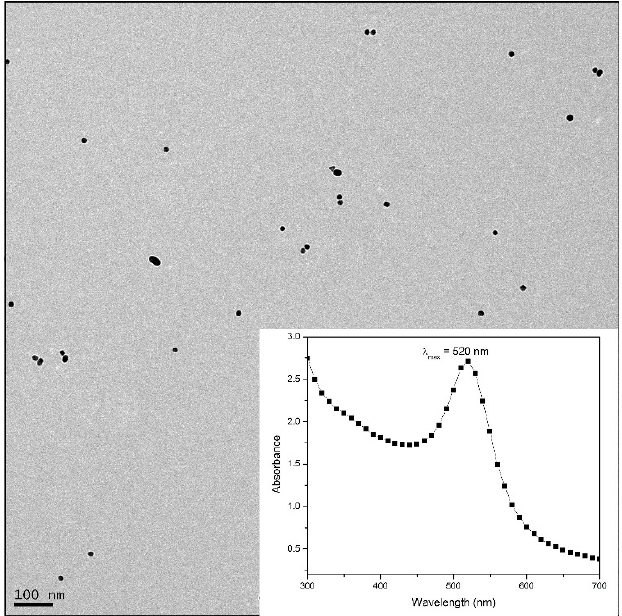
Figure 2. TEM of Au nanoparticles with the inset showing UV-Vis spectra of as-prepared AuNPs. A schematic representation of the technique used for the detection of gentamicin on the paper substrate is illustrated in Figure 3. Aptamers added to the gold nanoparticle suspension remained free in the absence of gentamicin, while shielding the interfering NaCl. The overall resulting color remained deep-pink indicating no color change. On the other hand, a color change to purple was observed when the gentamicin-specific aptamer interacted with the gentamicin present in the sample.